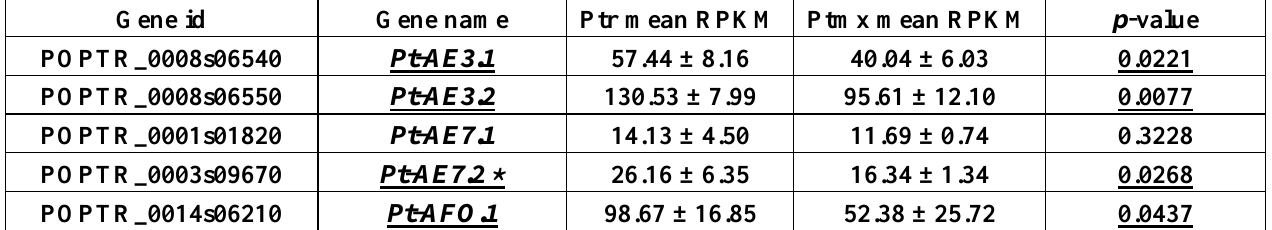
Table S2. Transcriptome data for leaf tissues comparing black cottonwood (Ptr) and hybrid aspen (Ptmx) expression levels (RPKM) analyzed using RT-PCR. Grey shading denotes genes that have higher expression (RPKM) in hybrid aspen, compared to black cottonwood. A significant difference in expression levels between two species is determined with p -value < 0.05 (underlined). Bolded genes indicate RPKM > 5 in either species. Asterisks (*) indicate genes that were analyzed further with